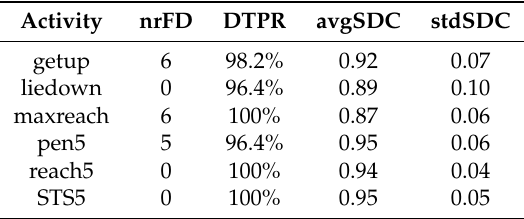
Table 4. Per-activity segmentation performance in terms of the number of false detections, detection true positive rate, average Sørensen–Dice coefficient and the SDC standard deviation. Activity nrFD DTPR avgSDC stdSDC getup 6 98.2%